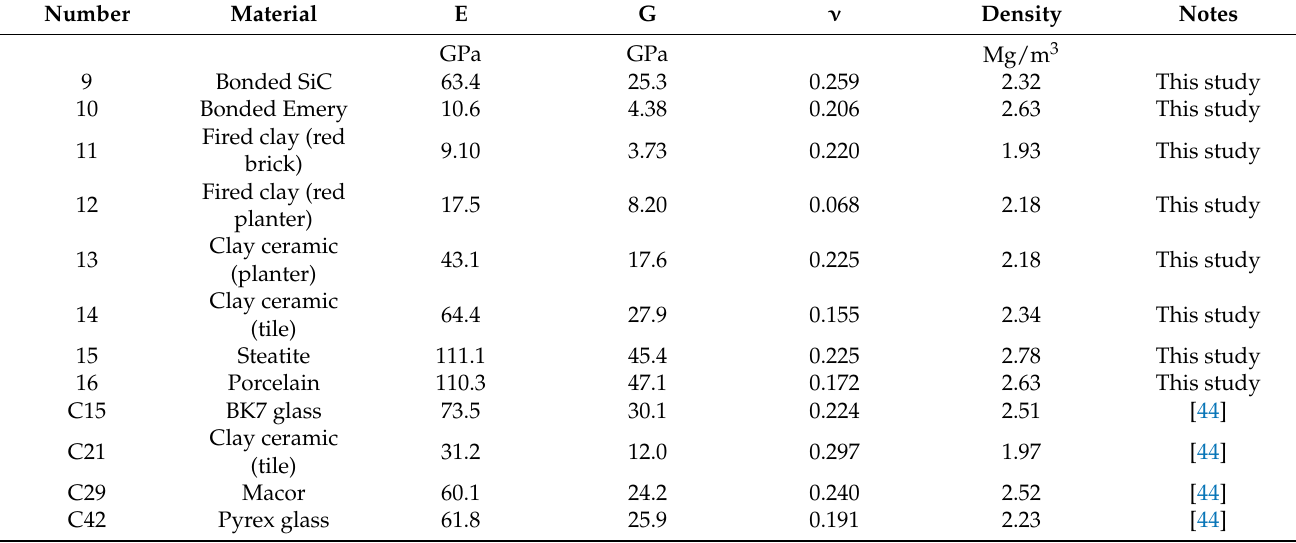
Table A1. Elastic constants of glasses and common